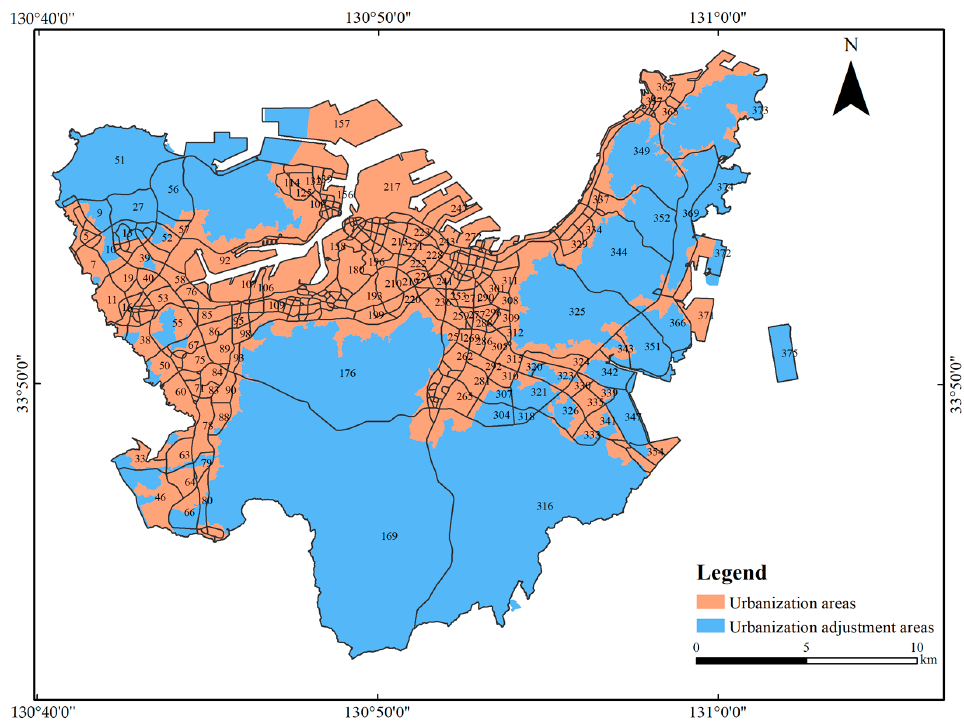
Figure 4. Units of the study area .